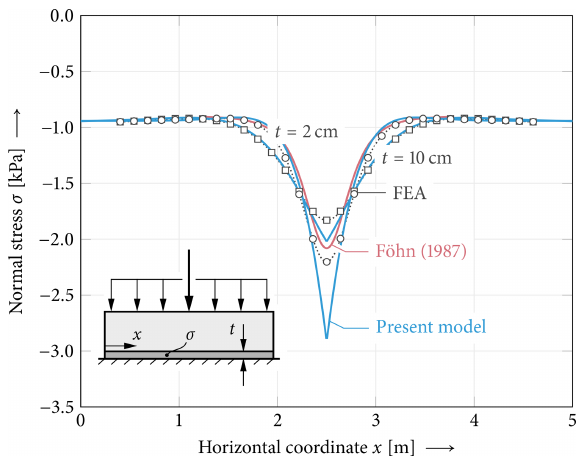
Figure 10. Mixed-mode energy release rates of propagation saw test (PST) configurations. The mode I (collapse) and mode II (shear) contributions of the energy release rates of a cut length a = 30cm are shown as a function of the slab thickness. Energy release rates are normalized with the respective initial value at ◦ = 0 . 805, G 15 ◦ = 0 . 007, G 30 ◦ = 0 . 770 and G 30 ◦ = h = 15cm: G 15 I II I II 0 . 028. Model parameters other than E weak = 0 . 15MPa and t = 5cm are chosen as given in Fig.